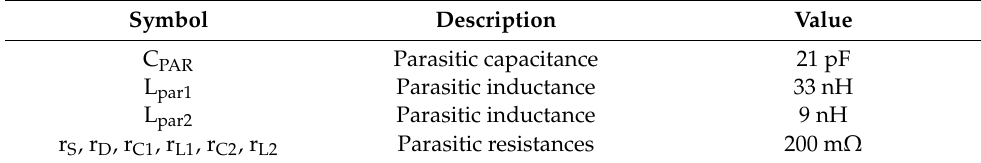
Table 3. Values of the parasitic components of the SEPIC converter model MCP1663.